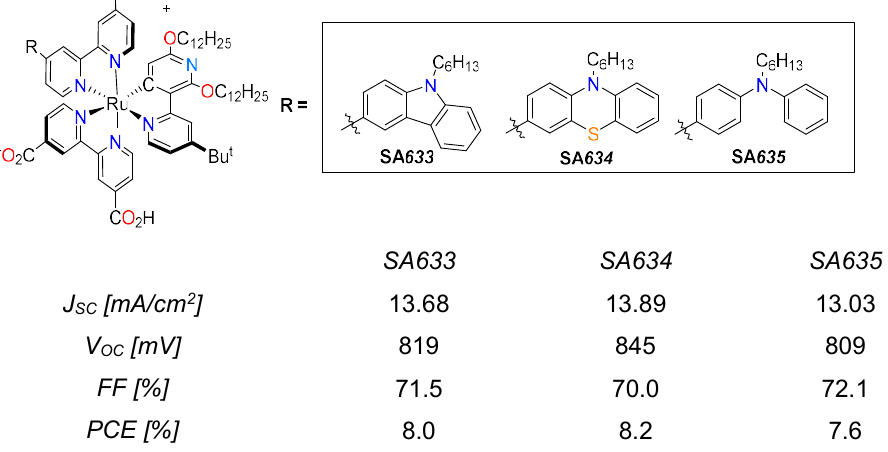
Figure 21 . Cyclometalated ruthenium complexes with arylamine electron donating groups and their performance in DSCs with Co-based electrolyte [115].